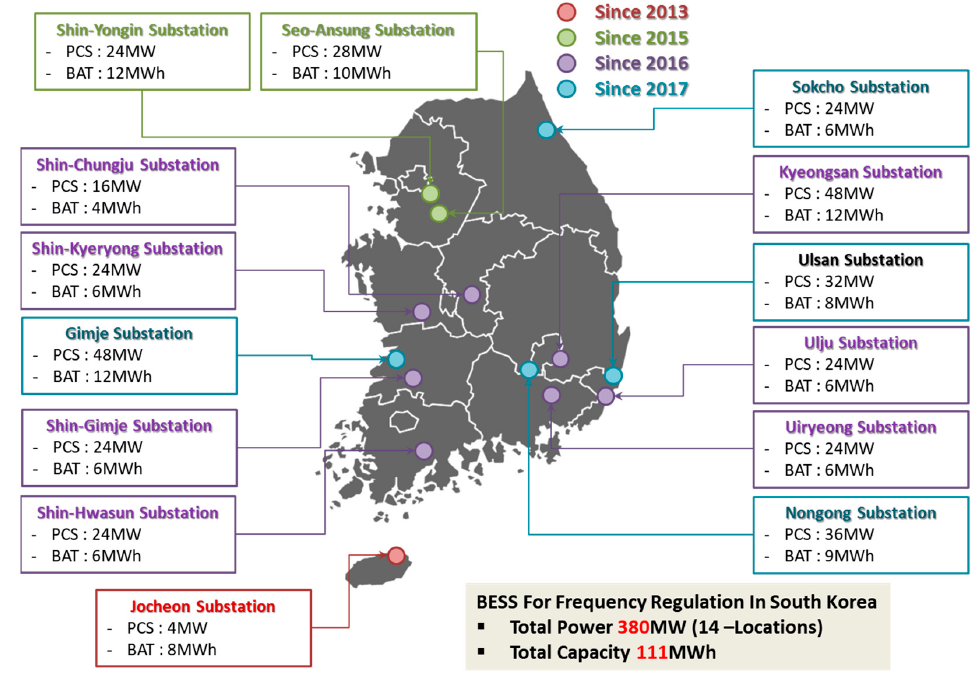
Figure 7. Installation status of BESS System for PFC in South Korea power grid (2013~2017).